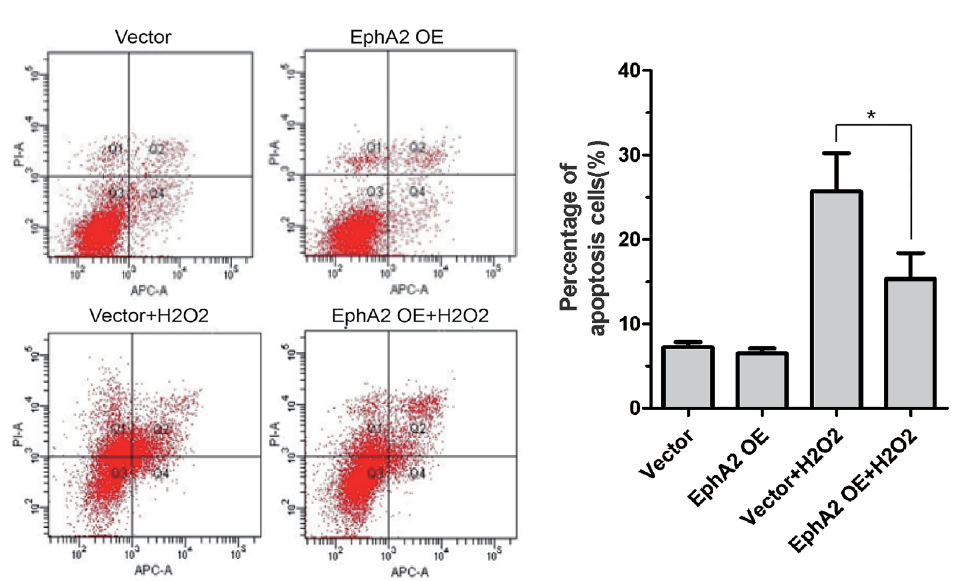
O -treated SRA01/04 cells. SRA01/04 cells were transfected with pIRES2-ZsGreen1-EphA2 2 2 O for 24 h. Flow cytometry was performed to estimate apoptosis of SRA01/04 cells. * P 2 2